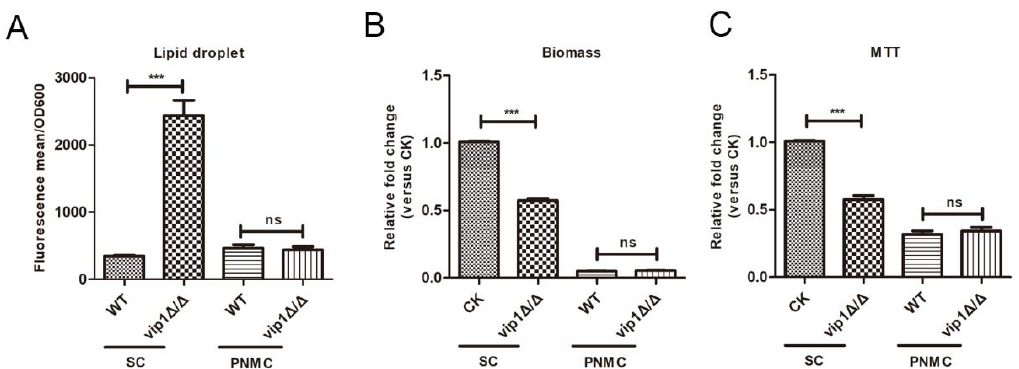
Figure 2. Pi regulation of LD deposition is a downstream event of energy metabolism. ( A ) Determi- nation of LDs. The strain was grown in SC or PNMC medium to the stationary phase, the strains were collected and the LD content was measured. ( B ) Biomass determination. Strains were grown in SC or PNMC medium to the stationary phase, and biomass was measured by OD 600 . ( C ) MTT assay for measuring mitochondrial succinate dehydrogenase activity, which characterizes the metabolic activity of the strain. CK: WT strain was grown in SC medium. *** p < 0.001, ns: no significance